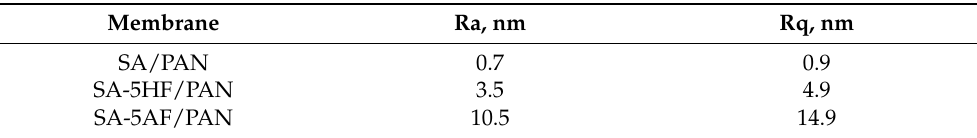
Table 3. The surface roughness parameters of the PAN-supported membranes based on SA and its composites with HF and